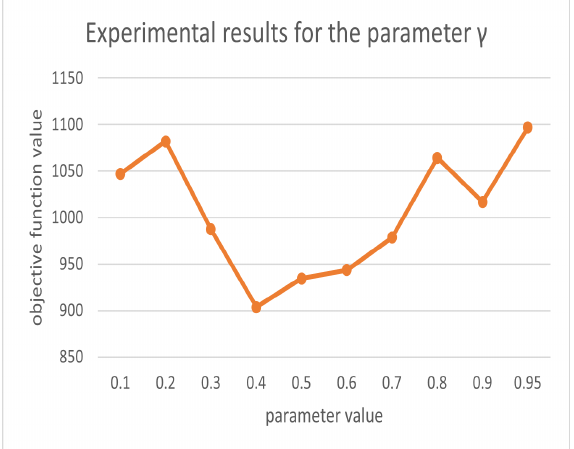
Figure 9. Experimental results for parameter γ